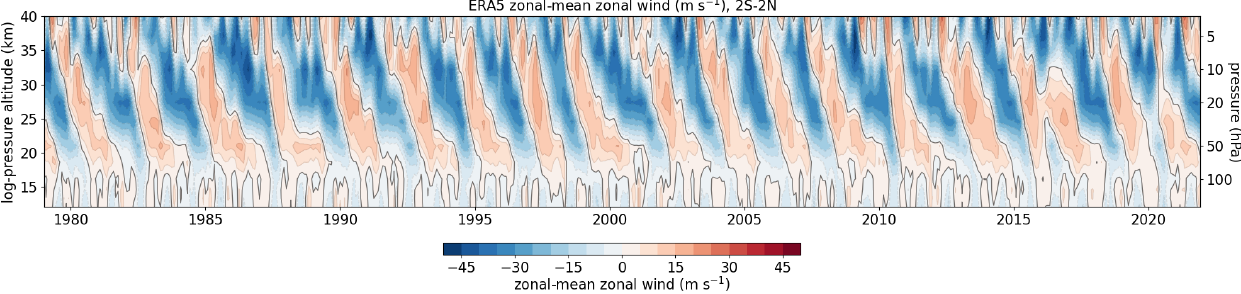
Figure 11. Equatorial QBO. Hovmöller diagram of the vertical profile of the monthly averaged, zonal mean zonal wind, averaged from 2 ◦ S to 2 ◦ N. Based on ERA5 data (Hersbach et al., 2020) for the 1979–2021. Figure is courtesy of James Anstey.